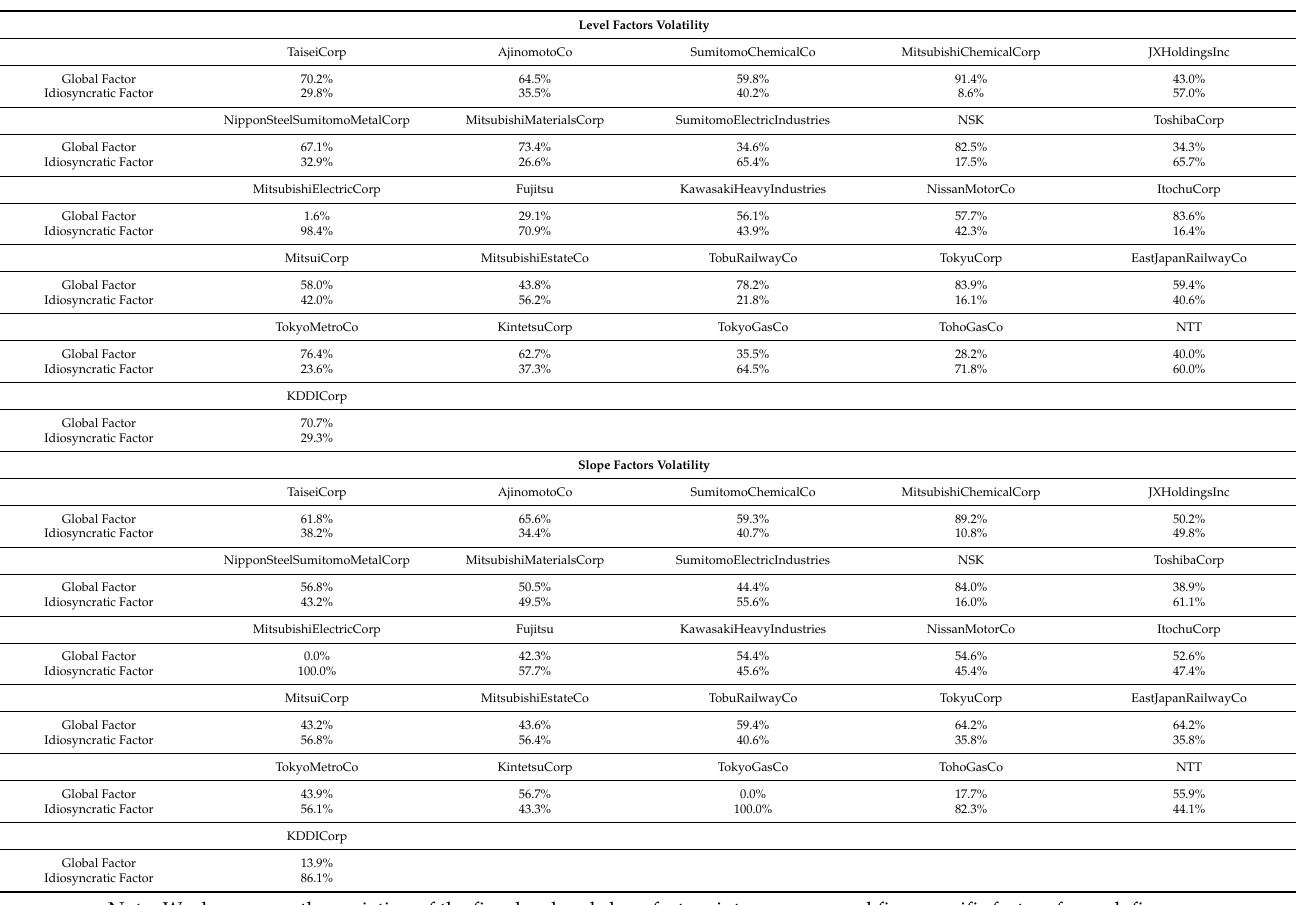
Table 1. Variance decompositions of the company level and slope